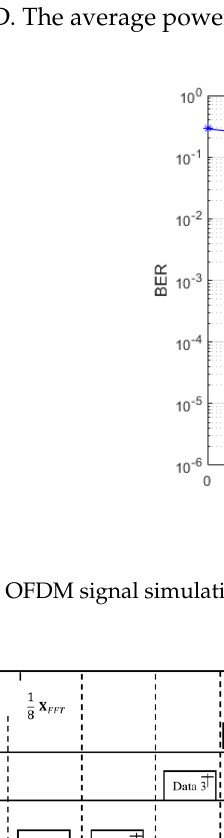
Figure 4. OFDM for VLP Hermitian